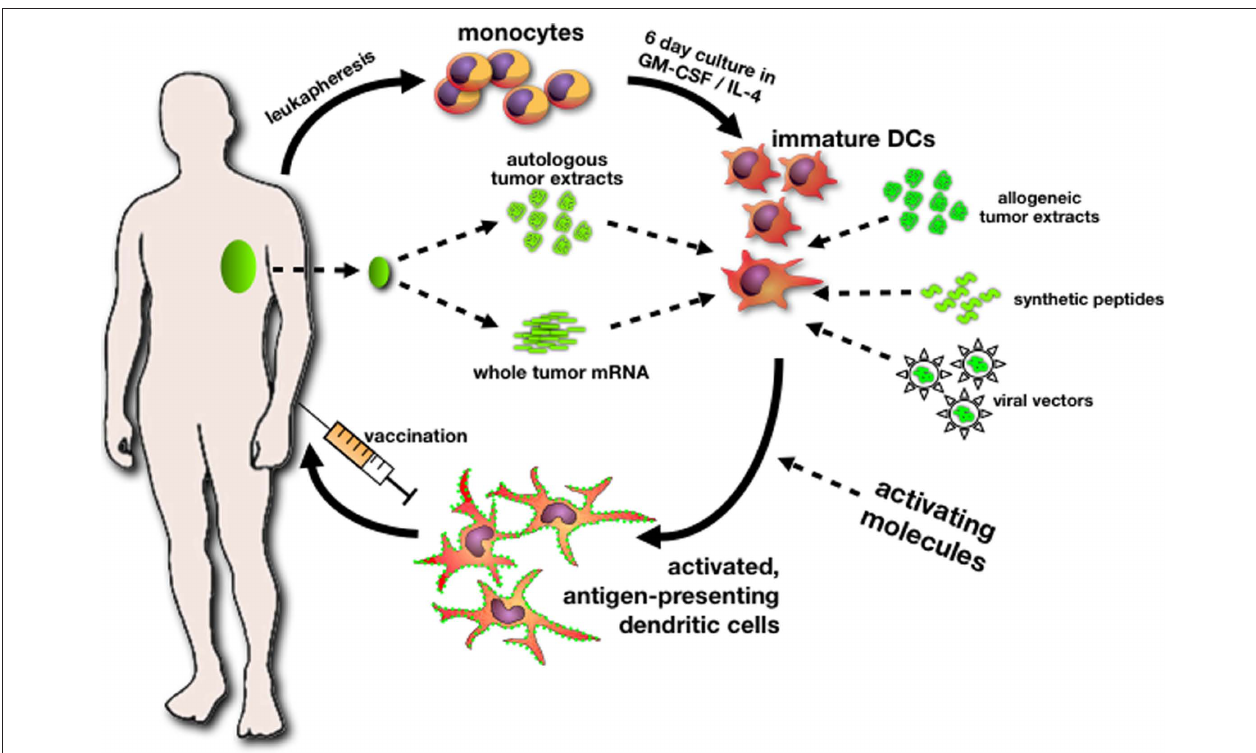
FIgURE 2 | A general workflow for the production of autologous dendritic cell vaccines for cancer immunotherapy. Monocytes, harvested from a leukapheresis, are differentiated in vitro under GMP-conditions into immature dendritic cells. The prototypical cytokines used for the generation of monocyte- derived DCs are GM-CSF and IL-4. Immature DCs can subsequently be loaded with tumor-derived antigens using different approaches: DCs can phagocytose proteins from autologous tumor lysate or be electroporated with tumor-derived